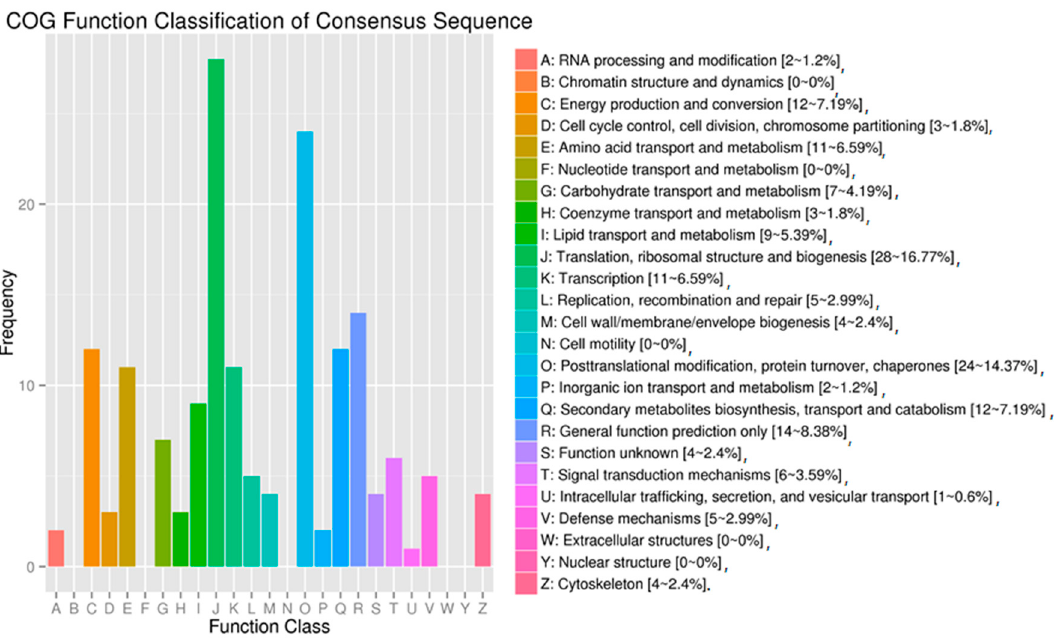
Figure 3. Clusters of orthologous groups (COG) classification of common differentially expressed genes (DEGs) that were detected in both comparisons of LT vs. CK and HL vs. CK in B. semperflorens leaves. LT, low temperature-treated plants; HL, high light-treated plants; CK, control plants.